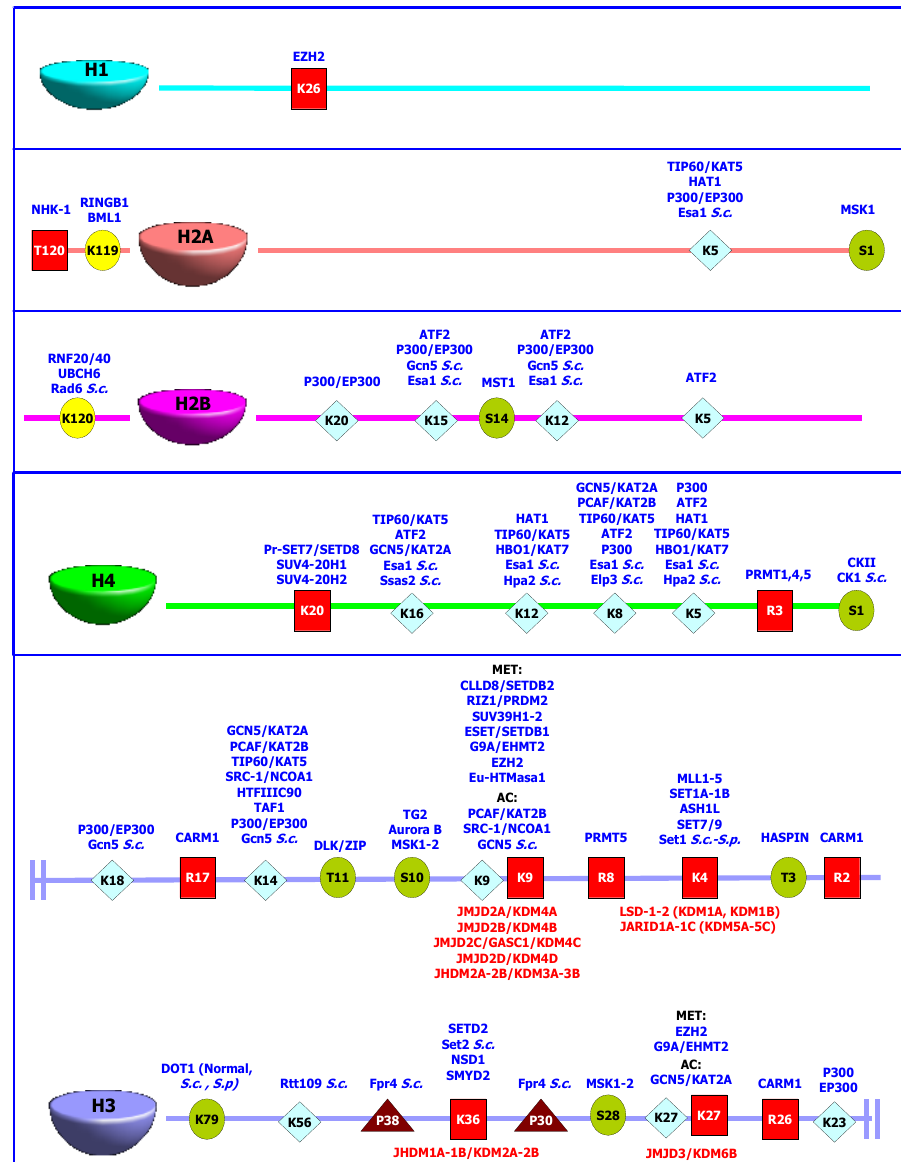
Figure 1. Post-translational modifications of histone proteins H1, H2A, H2B, H3 and H4 involved in epigenetic regulation. Target amino phosphorylation ( ● ), ubiquitination ( ● ), acetylation ( ♦ ) or methylation ( ■ ) are shown